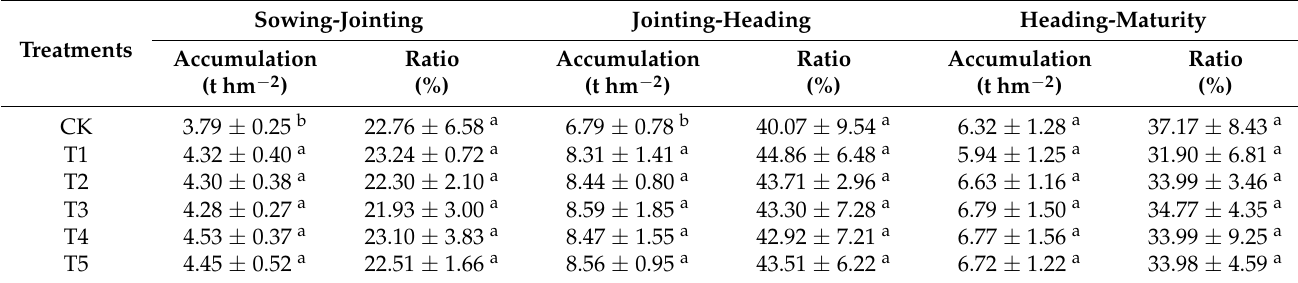
Table 3. Dry matter accumulation and proportion in different growth stages of rice under different ZnO NPs application amounts.